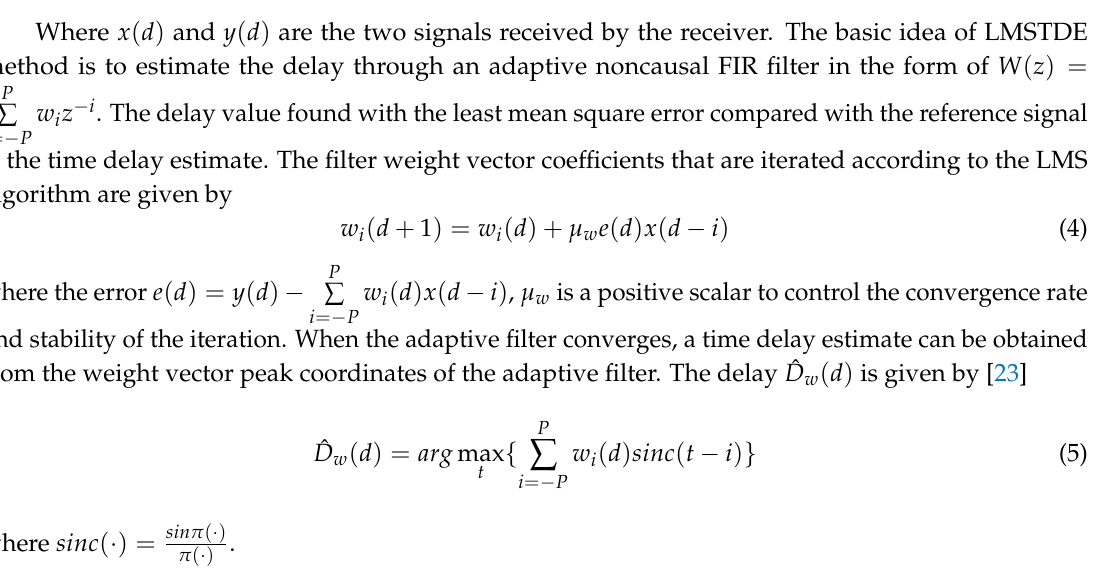
Figure 6. Block diagram of